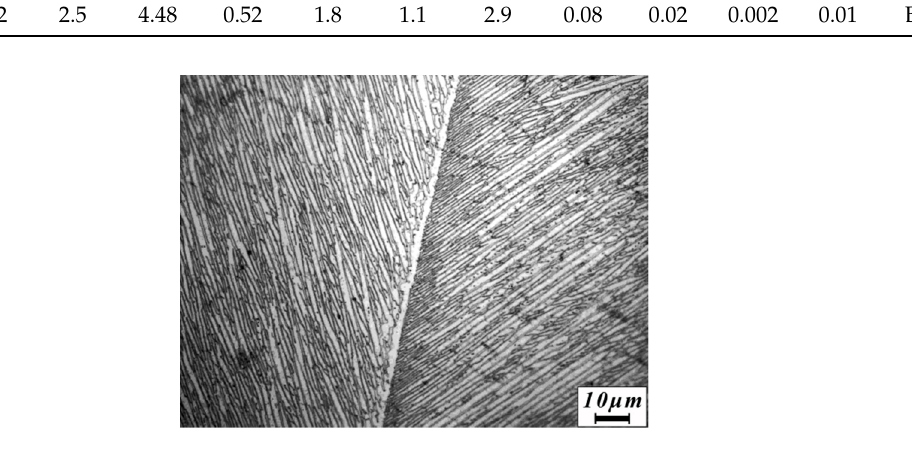
Figure 1. Original microstructure of the as-cast titanium alloy.